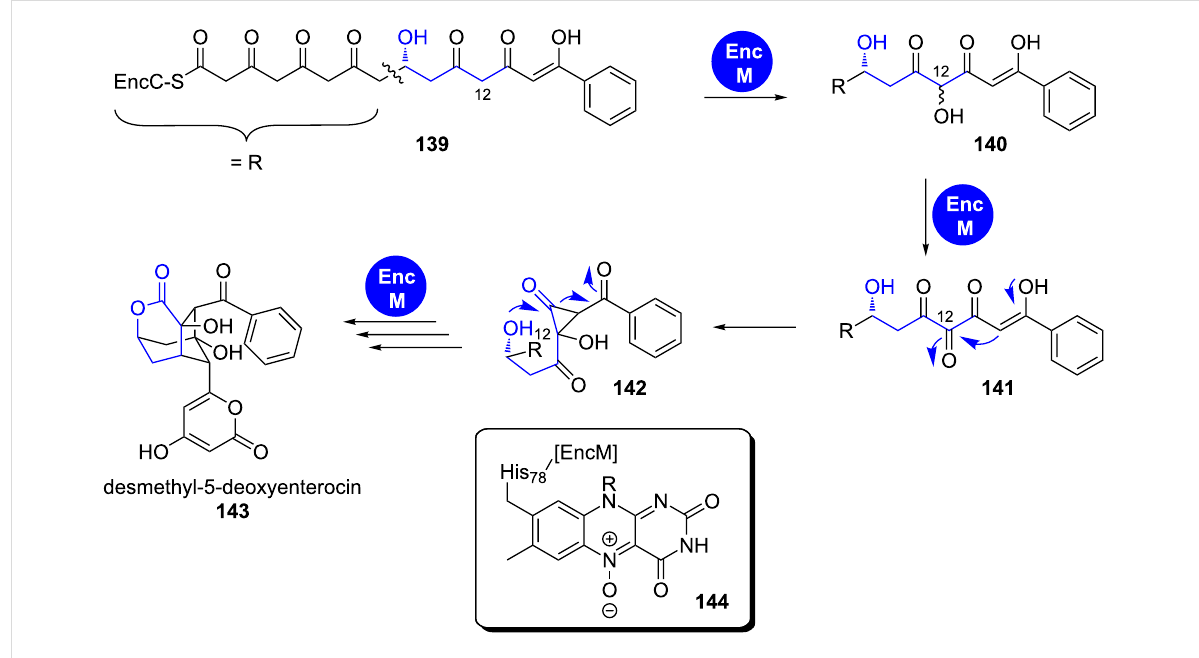
respective functional groups. Besides a common antibacterial activity, many tetronates also have further attractive bioactivi- ties that triggered interest in their research [139,140].